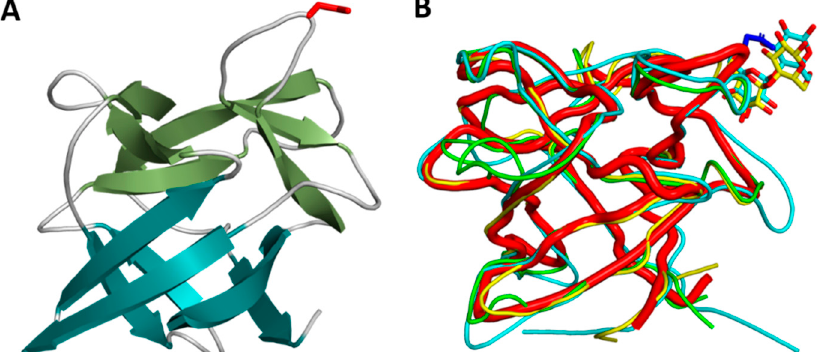
Figure 3. Three-dimensional structure of cocaprin 1. ( A ) Crystal structure of CCP1 (7ZNX). β -strands in the trunk shown in teal and β -strands in the crown shown in green. The N22 residue involved in the inhibition of cysteine protease is shown as red sticks; ( B ) structural superposition of CCP1 (red thick ribbons) with MpL (yellow), CNL (cyan) and the designed trefoil protein (green). The lactose molecules in CNL and MPL (shown as sticks) bind in the same region as the cysteine proteases in CCP1.